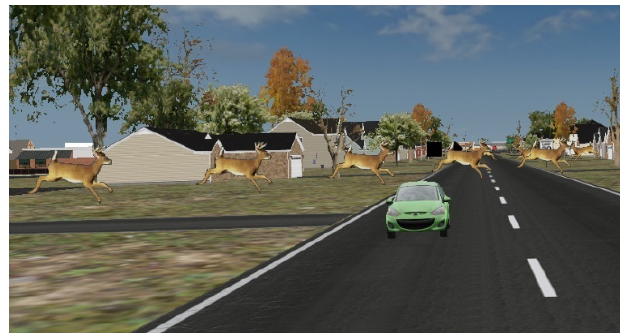
Figure 10. Animal crossing (challenge).